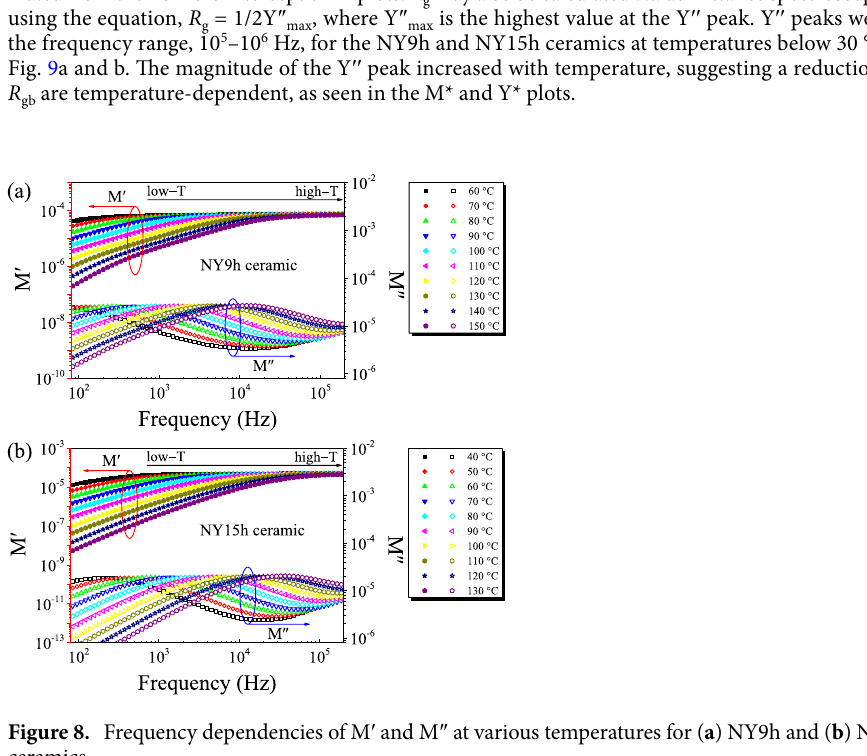
Figure 8. Frequency dependencies of M ′ and M ″ at various temperatures for ( a ) NY9h and ( b ) NY15h